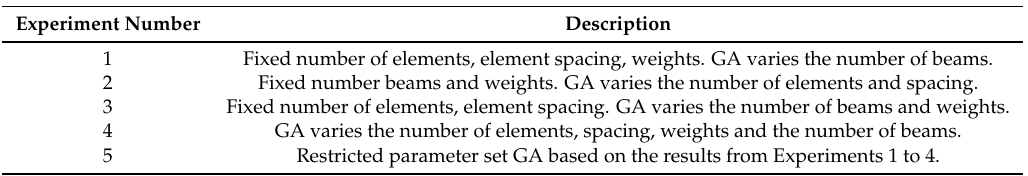
Table 4. Experiment descriptions.